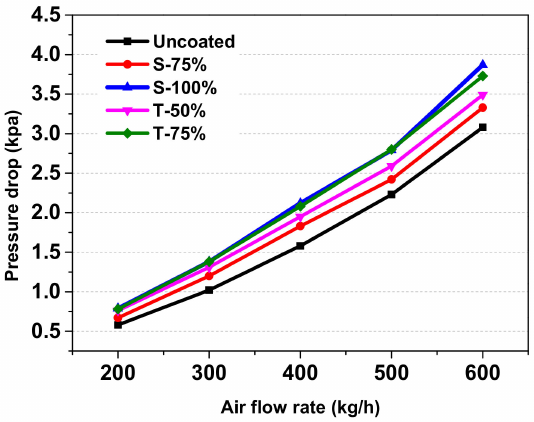
Figure 8. Influence of catalysts coating on GPF cold flow pressure drop.